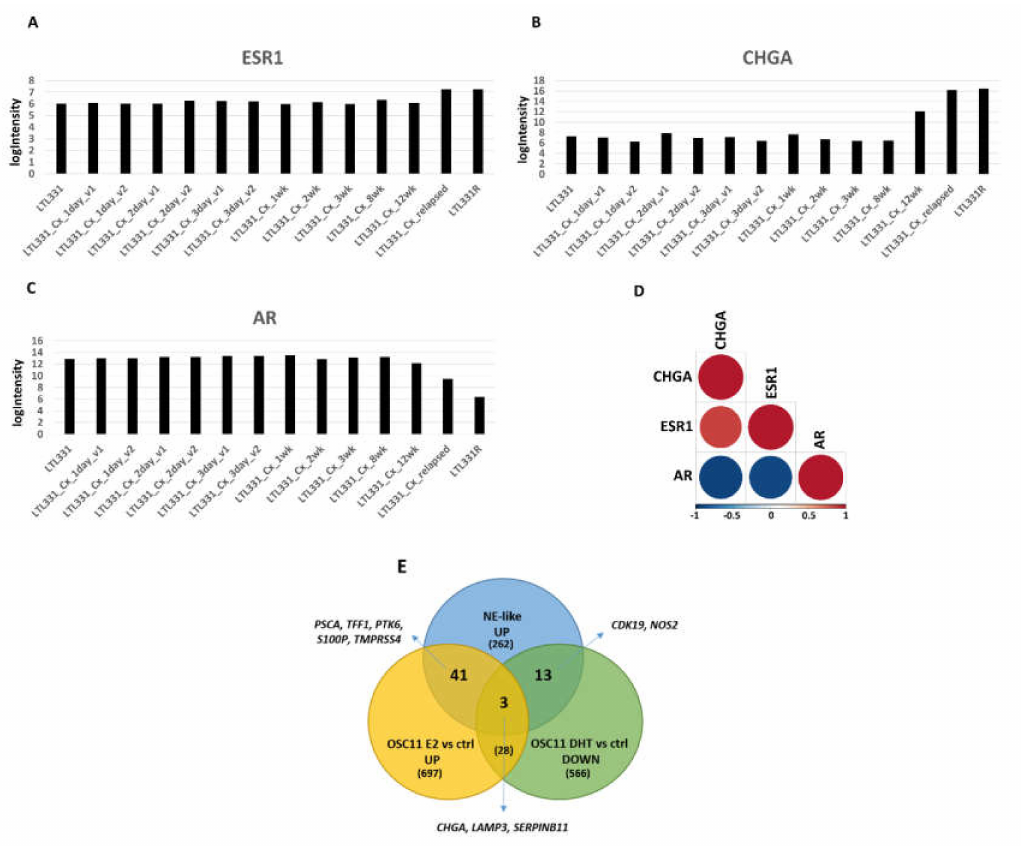
Figure 4. ( A – D ) PDX model of NEPC progression evaluated from prostate adenocarcinoma before castration(LTL331)torelapsedneuroendocrinetumor(LTL331R)[16]. ESR1( A )andCHGA( B )increased their expression throughout the transdi ff erentiation process, with concomitant AR down-regulation ( C ). ( D ) Correlation matrix showing a high positive correlation between ESR1 and CHGA (Pearson’s correlation coe ffi cient = 0.86, p -value = 7.27 × 10 − 5 ) and a negative correlation between ESR1 and AR (Pearson’s correlation coe ffi cient = − 0.89, p-value = 1.54 × 10 − 5 ) and between AR and CHGA (Pearson’s correlation coe ffi cient = –0.91, p -value = 6.11 × 10 − 6 ). ( E ) The overlap between up-regulated genes in NE-like vs. AdenoPCa samples and genes up-regulated in OSC11 upon treatment with estradiol (E2) or genes down-regulated in OSC11 upon treatment with DHT, with extrapolation of some genes of